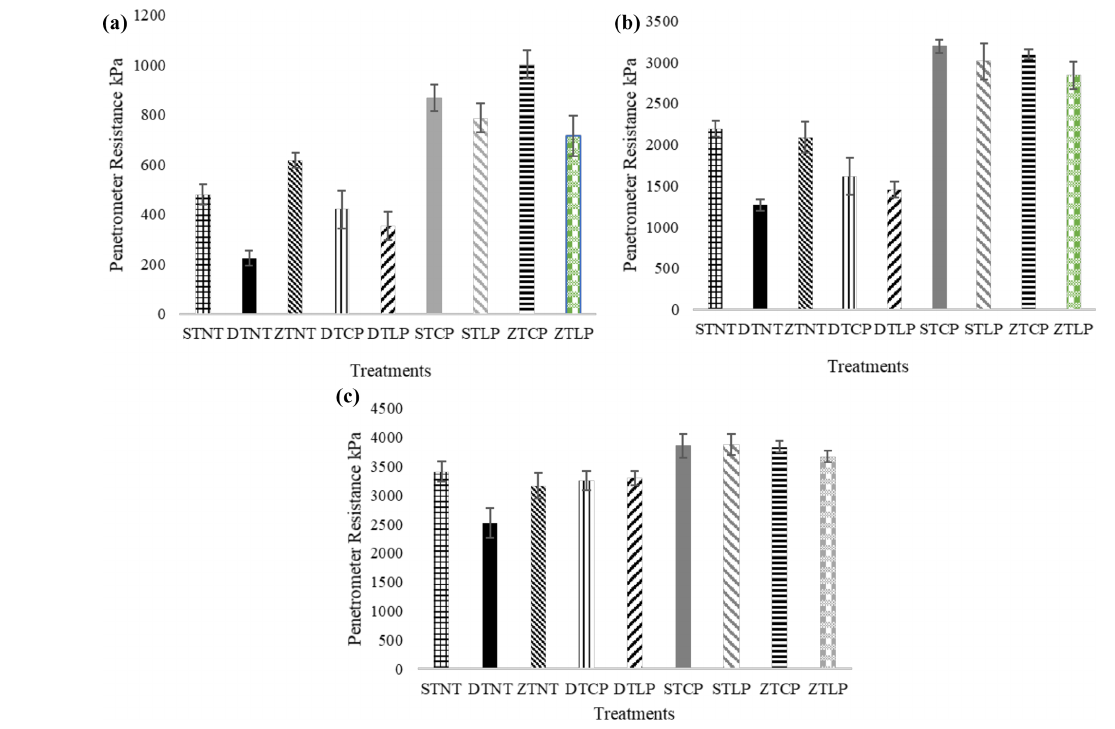
Figure 1. Penetration resistance (kPa) for three layers, namely (a) 0–150mm ( P< 0 . 000), (b) 150–300mm ( P< 0 . 000), and (c) 300–450mm ( P< 0 . 000), during wheat tillering (GS 25). Soil moisture conditions were at field capacity during sampling. Bars represent the standard error of the mean.